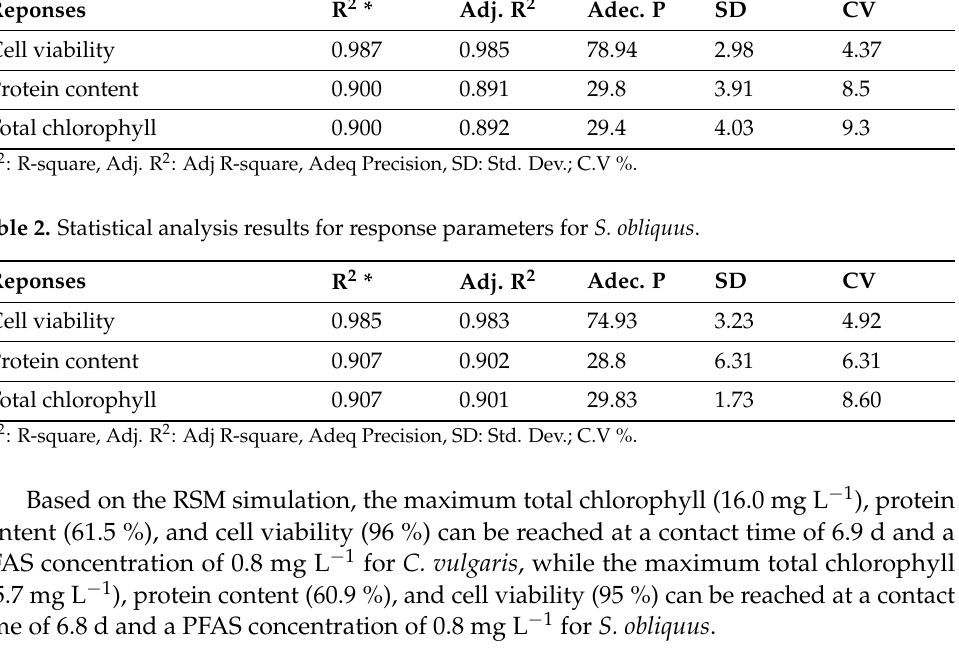
Table 1. Statistical analysis results for response parameters for C. vulgaris . Reponses R 2 * Adj. R 2 Adec. P SD CV Cell viability Protein content